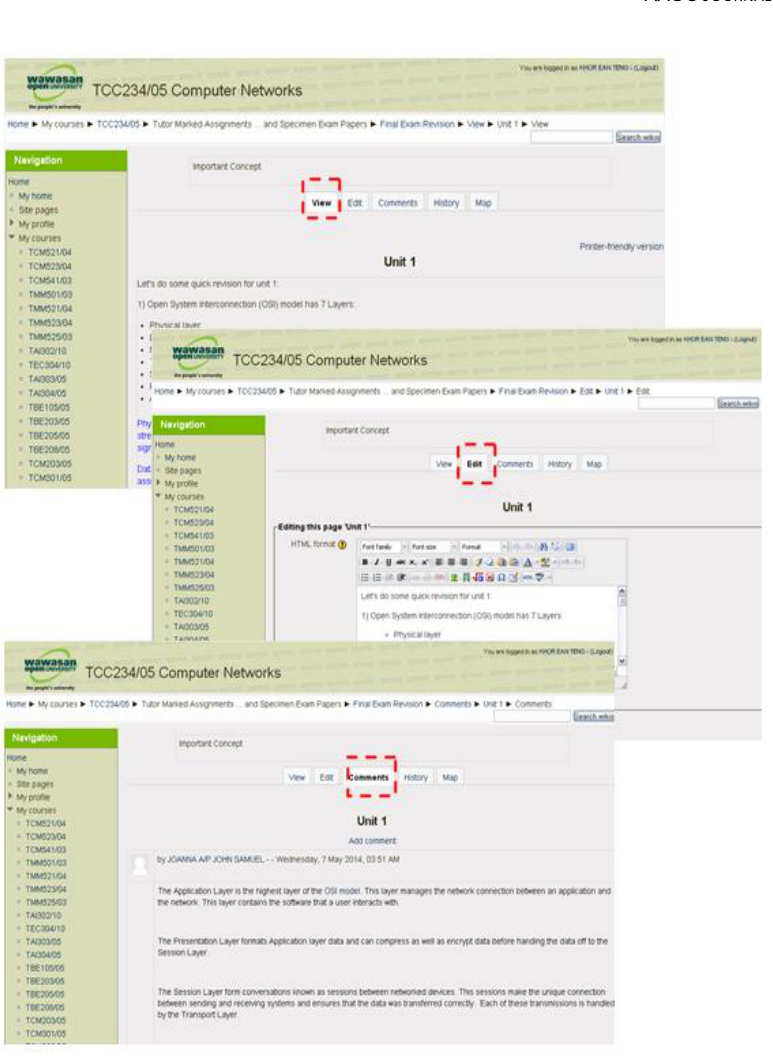
Figure 2 Moodle-wiki screen